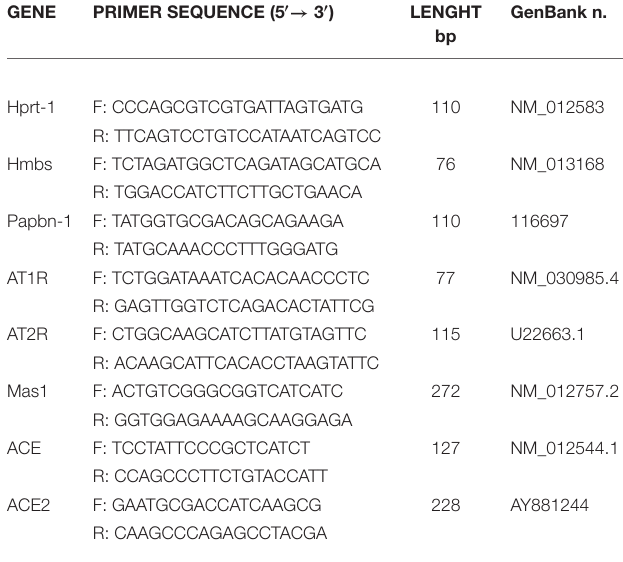
TABLE 1 | Reference and target genes: primer